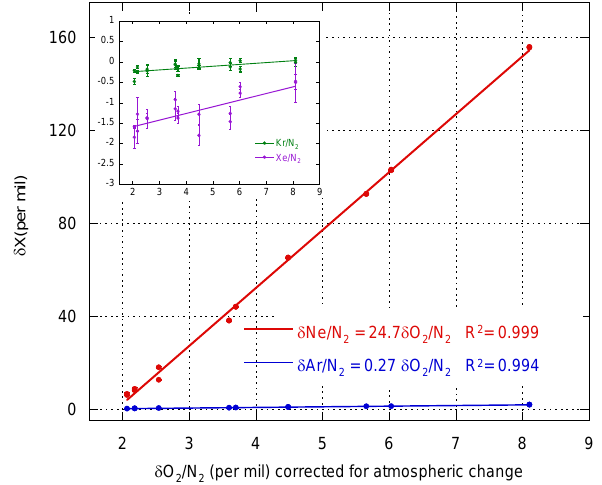
Fig. 5. Isotopic ratios of O 2 and N 2 in the lock-in zone. The solid line is an orthogonal linear fit to the data, while the dashed 2:1 line shows what is expected from conventional mass-dependent frac- tionation. Residuals to the orthogonal fit show some dependence on δ 15 N, raising the possibility that a linear model may not describe these data well. Shown are measurements of both NOAA and PSU flask from 68 . 26m and